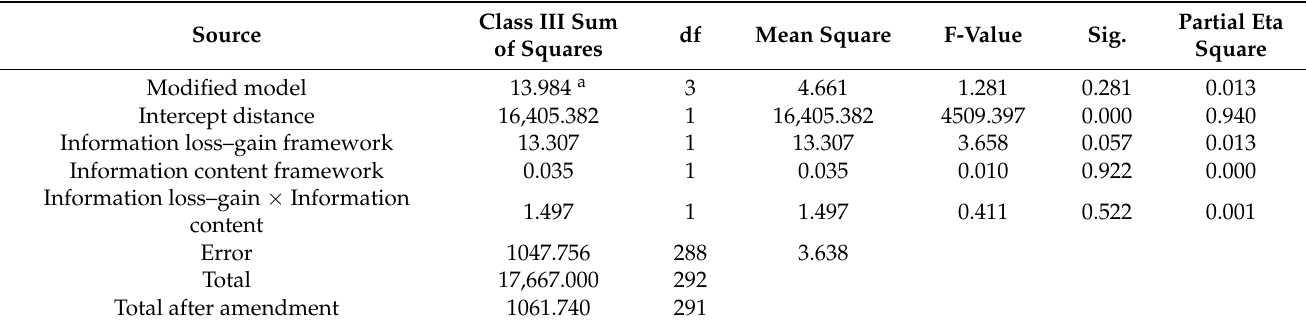
Table 6. Inter-subject effects